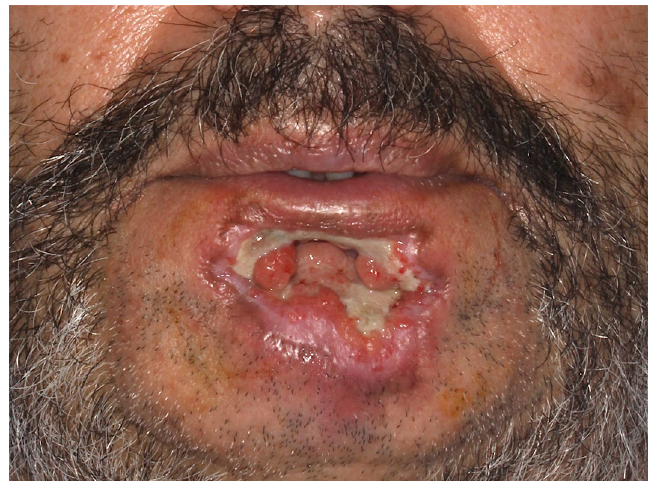
Figure 12. Patient after prolonged COVID-19 treatment requiring respirator use for multiple weeks resulting in severe damage to the skin of the lower